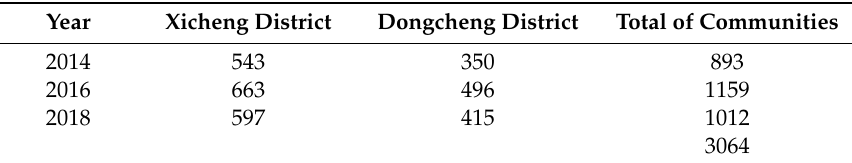
Table 1. Transaction sample